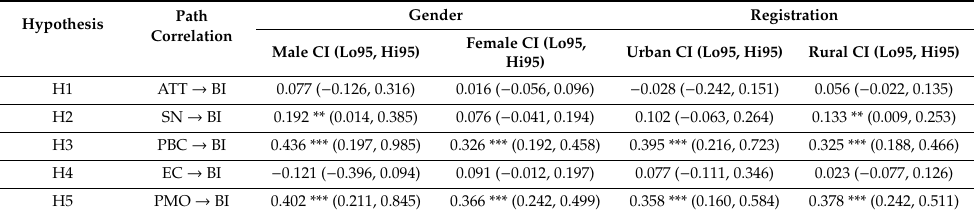
Table 7. Multi-group structural equation analysis results (standardized path coe ffi